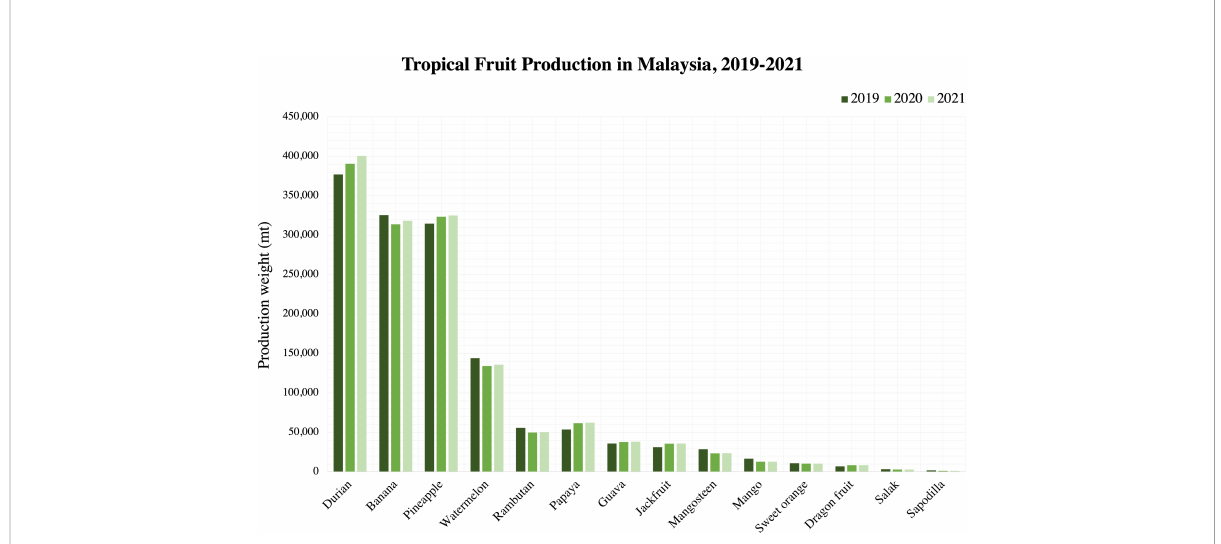
FIGURE 2 Tropical fruit production in Malaysia, 2019-2021. Source: Department of Agriculture, Malaysia